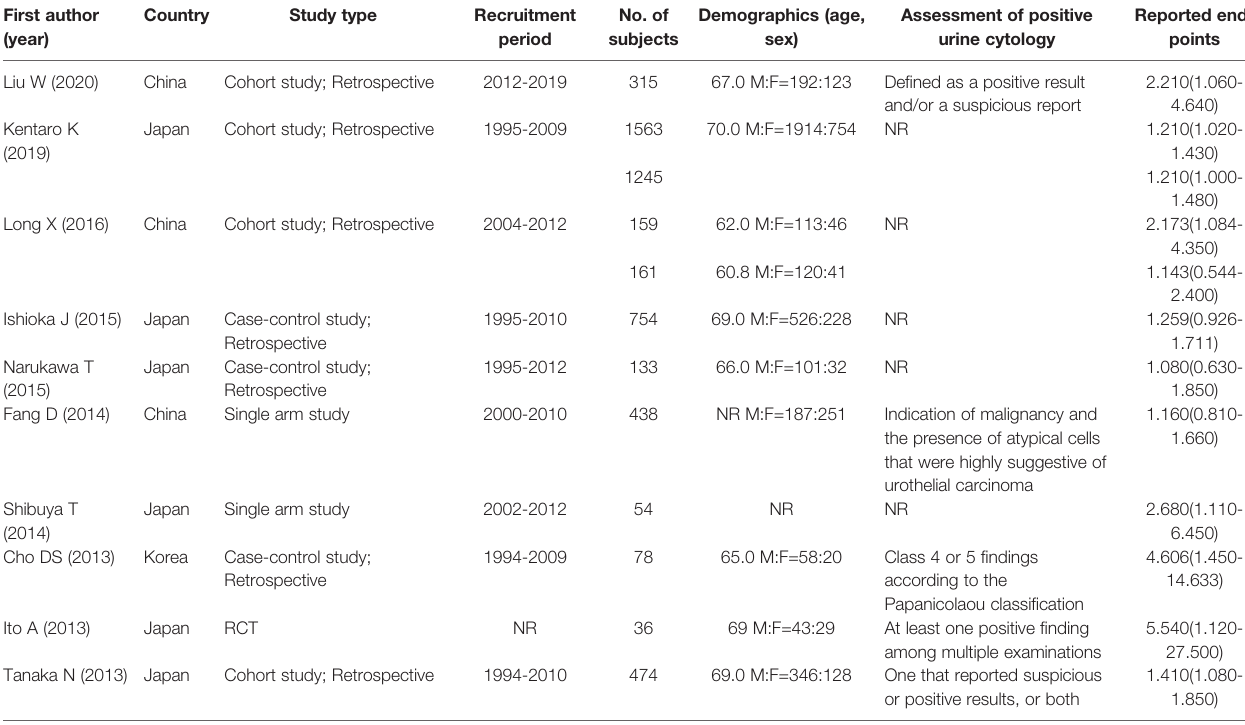
TABLE 5 | Main characteristics of studies about the intravesical recurrence-free survival included in the